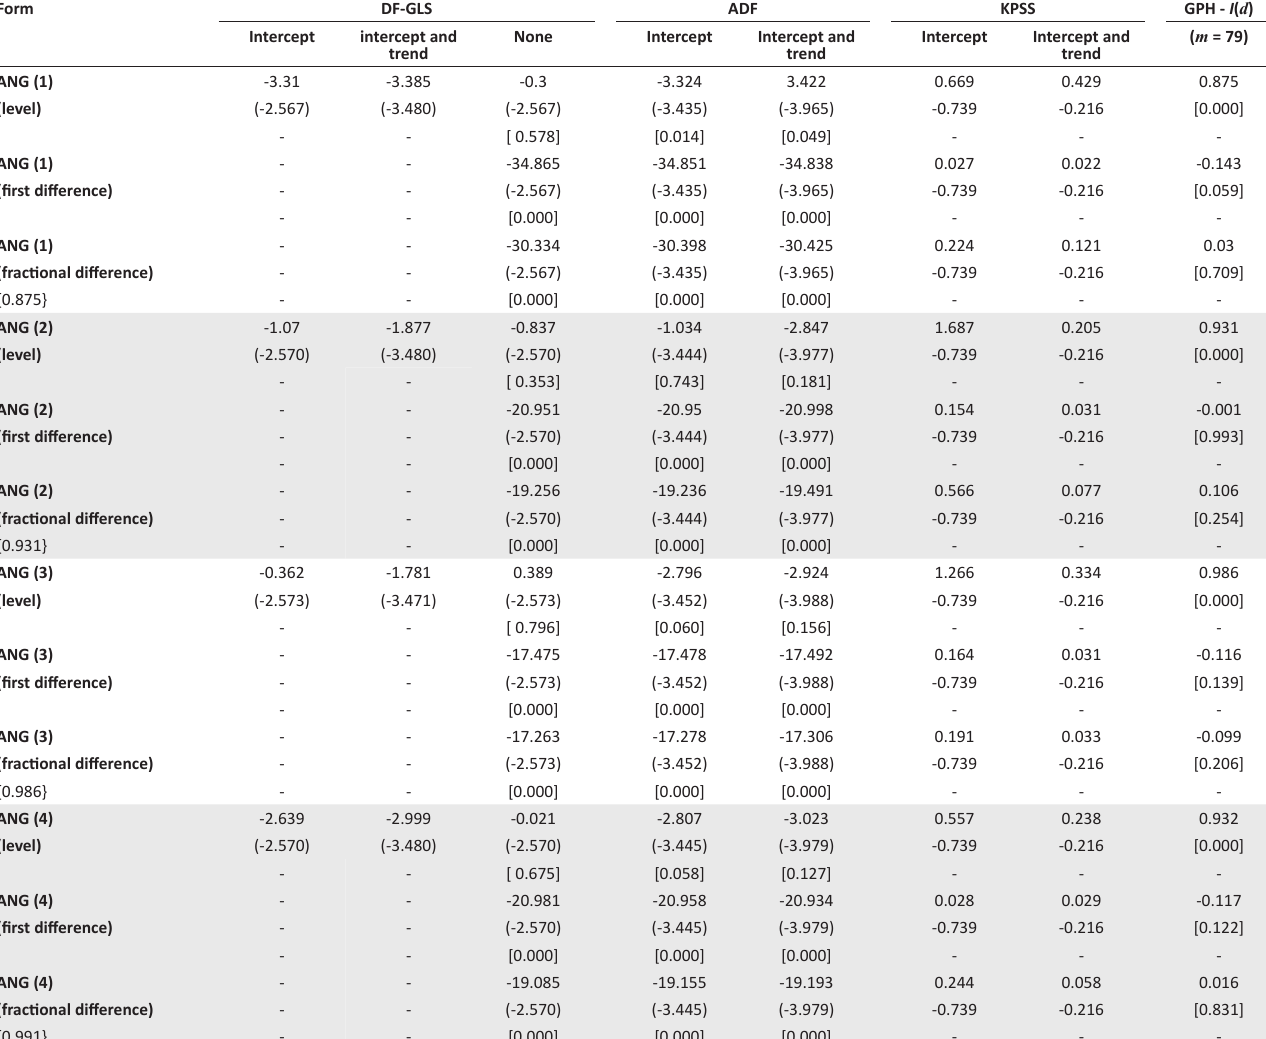
TABLE A1 (Continues...): Determining the correct form of